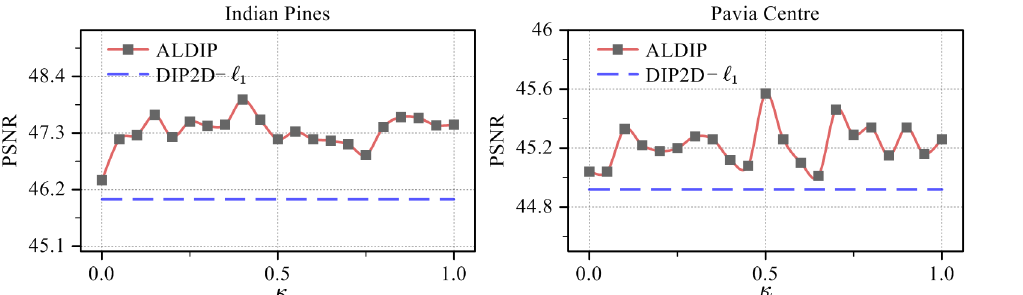
Figure 11. The trend of PSNR changing with the initial value of κ on Indian Pines (case 8) and Pavia Centre (case